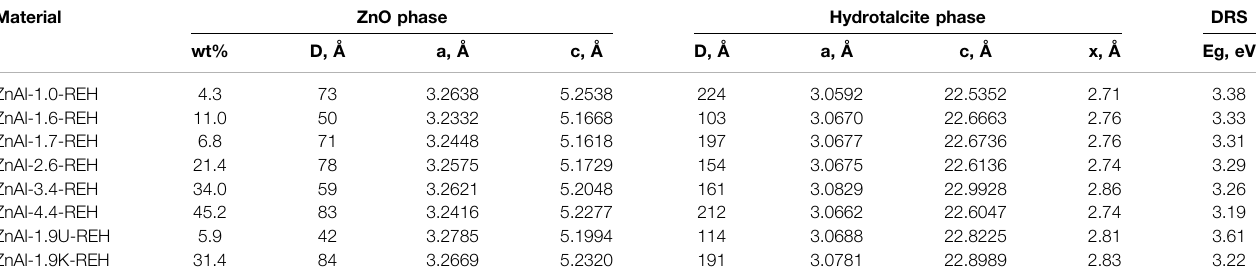
*x is width of interlayer.